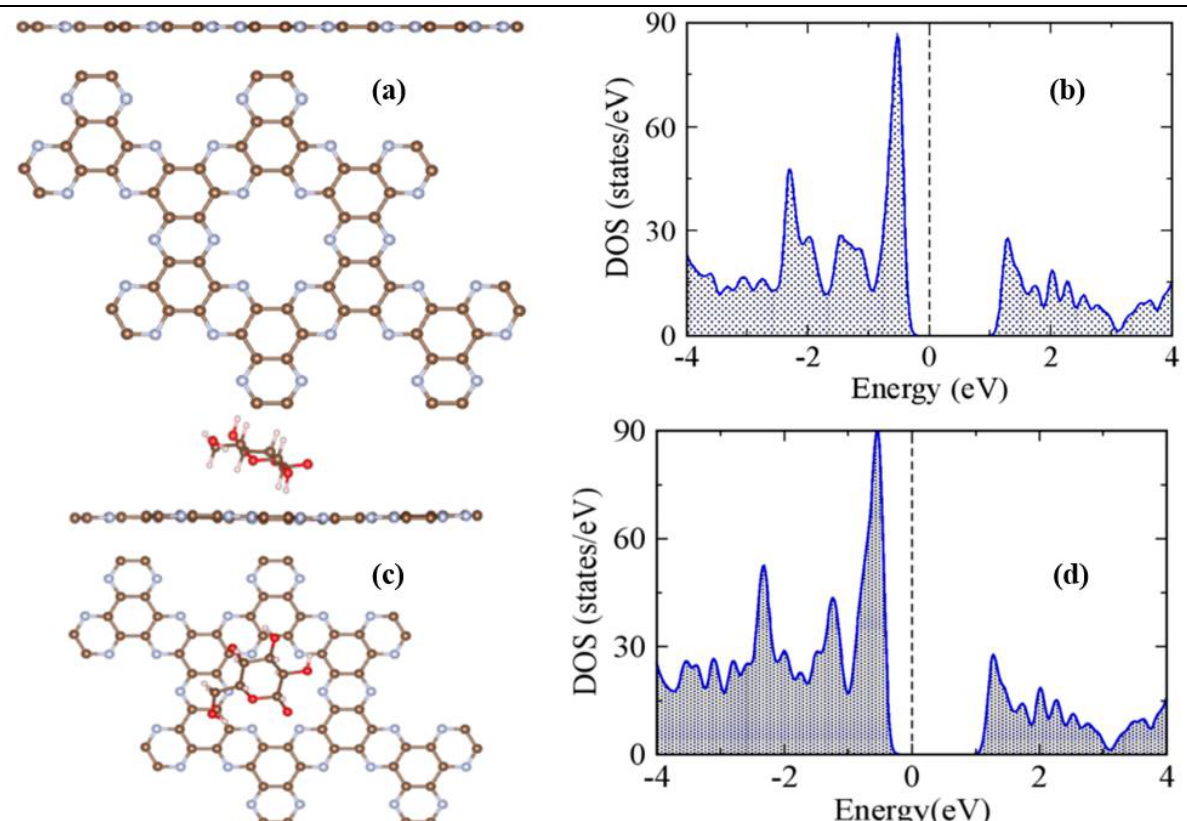
Figure 13. Optimised geometries and DOS of ( a , b ) 2 × 2 × 1 C 2 N monolayer ( c , d ) Glucose adsorbed C 2 N. Reprinted from Ref. [195].